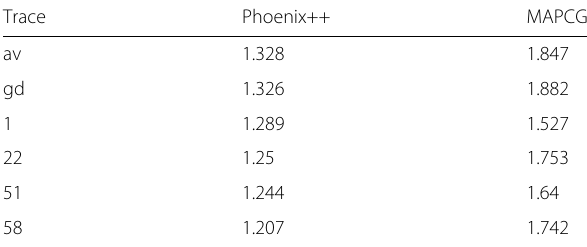
Fig. 5 Memory usage of the parallel